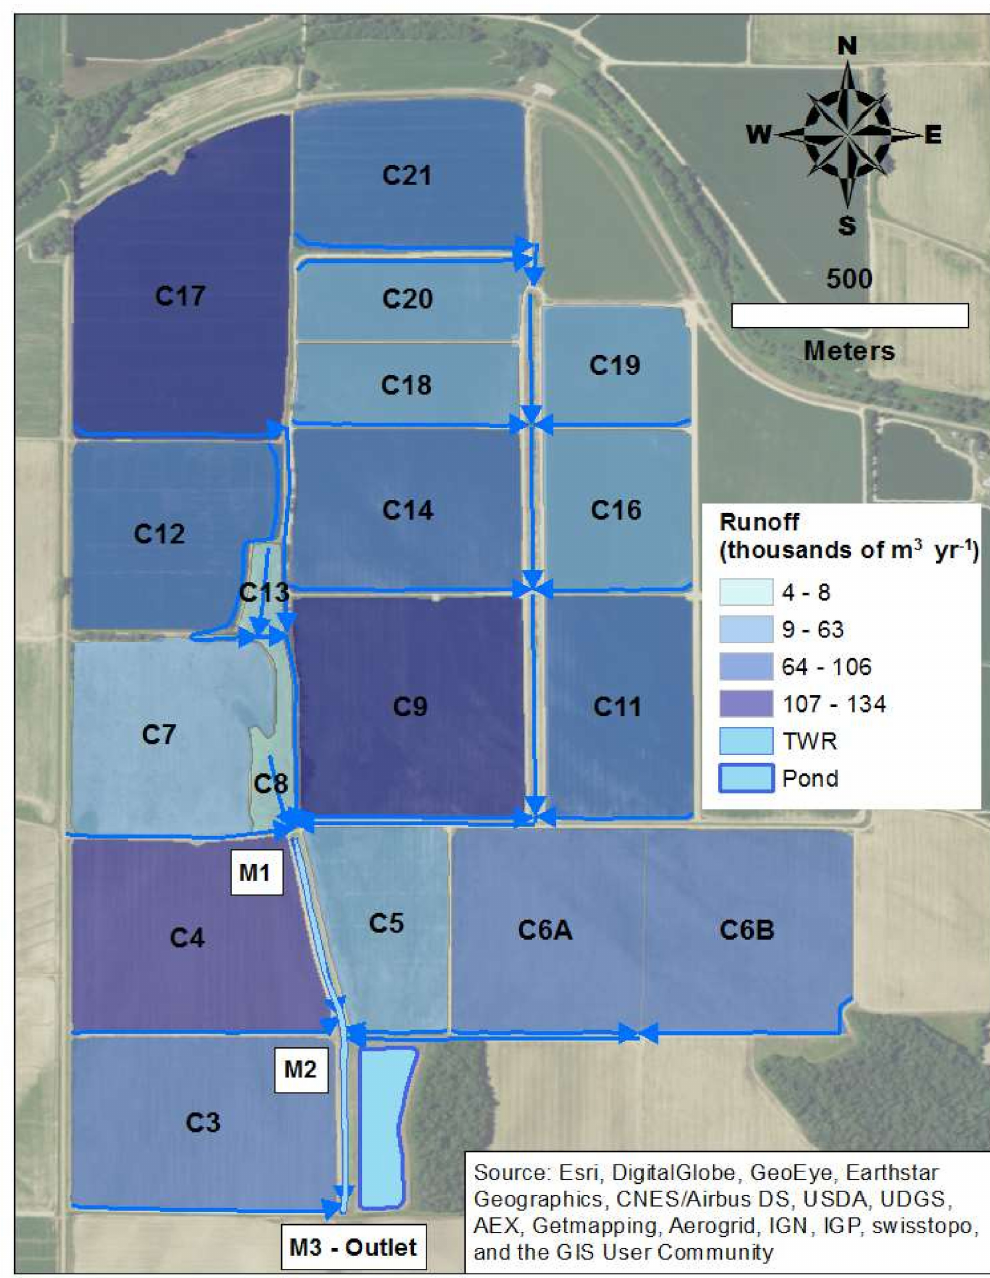
Figure 3. Map of the study area showing the average annual runo ff production in the simulated watershed. The blue arrows represent the runo ff flow direction towards the outlet. (M1: TWR inlet; M2: TWR mid-canal; M3: TWR outlet; labels within fields indicate the subwatershed identification used by the AnnAGNPS